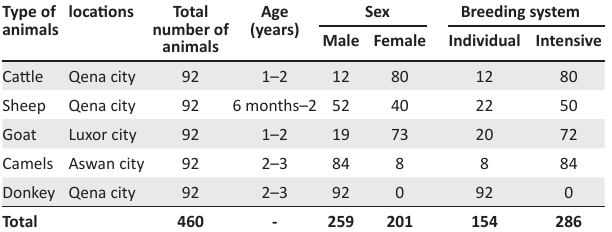
Sudan TABLE 2: Infection rate of Rift Valley Fever in cattle, sheep, goat, camel and